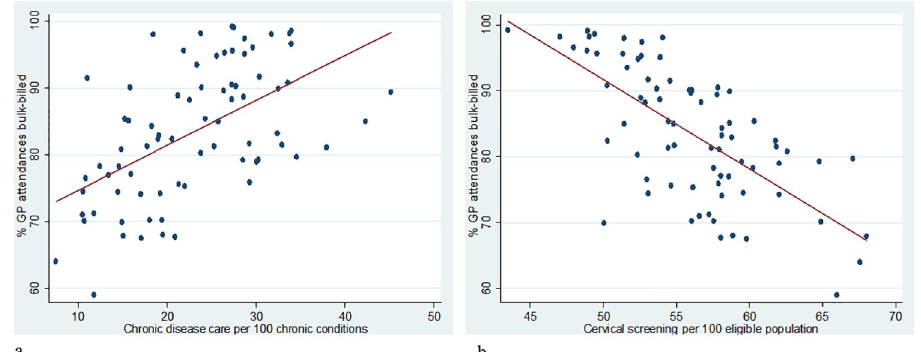
Fig 3. Relationship between dimensions of area PHC service characteristics: Scatterplot of bulk-billing with (a) CD care and (b) cervical screening. Abbrev. PHC primary health care; GP, general practice; CD, chronic disease. Eligible population for cervical screening is percentage of women aged 20–69 who have participated in cervical screening. Red line represents line of best fit.